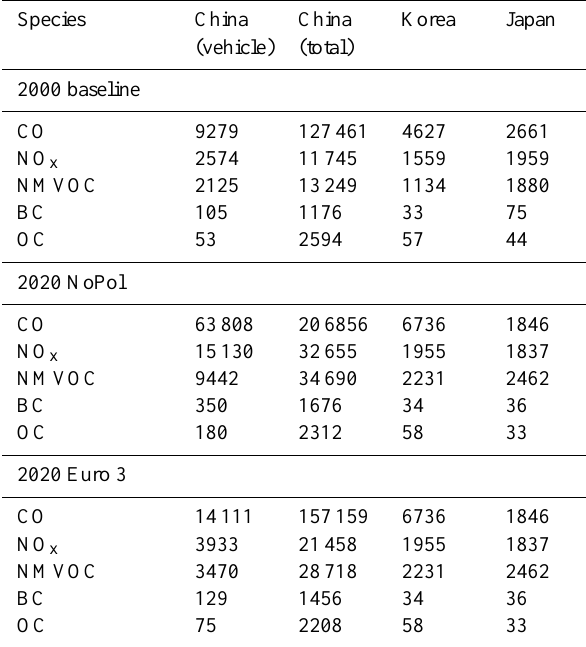
Table 4. Total anthropogenic emissions for each scenario in China (vehicle, total), Korea and Japan (ktyear − 1 ).